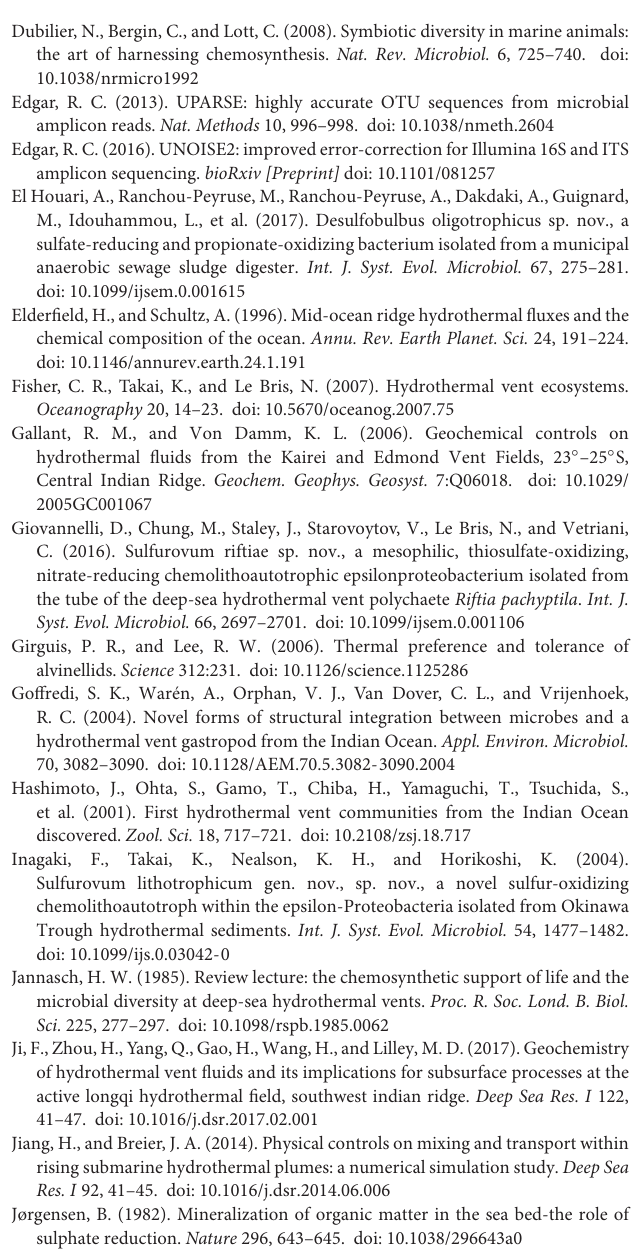
Supplementary Figure 3 | NMDS analysis of the microbial communities separated the samples into two principal groups, one composed of the samples of SFSs collected from the Kairei vent field, and another group composed of SFS samples collected from the Longqi vent field (A) . Although the samples of Kr and Kr16 grouped together, they were in a loose pattern with no significant difference (C) . However, the microbial community structures of Kr and Kr16 were clearly separated from the microbial community of Lq (B,D) . The results based on the ASVs datasets. Supplementary Figure 4 | Stacked bar chart showing the relative abundance of microbial communities from all samples at phylum and class levels (A) , order level (B) , family level (C) , and genus level (D) . The results based on the ASVs datasets. Supplementary Figure 5 | The importance (A) and the heatmap (B) of the 20 most important OTUs, which distinguished the samples of Kr and Lq. The